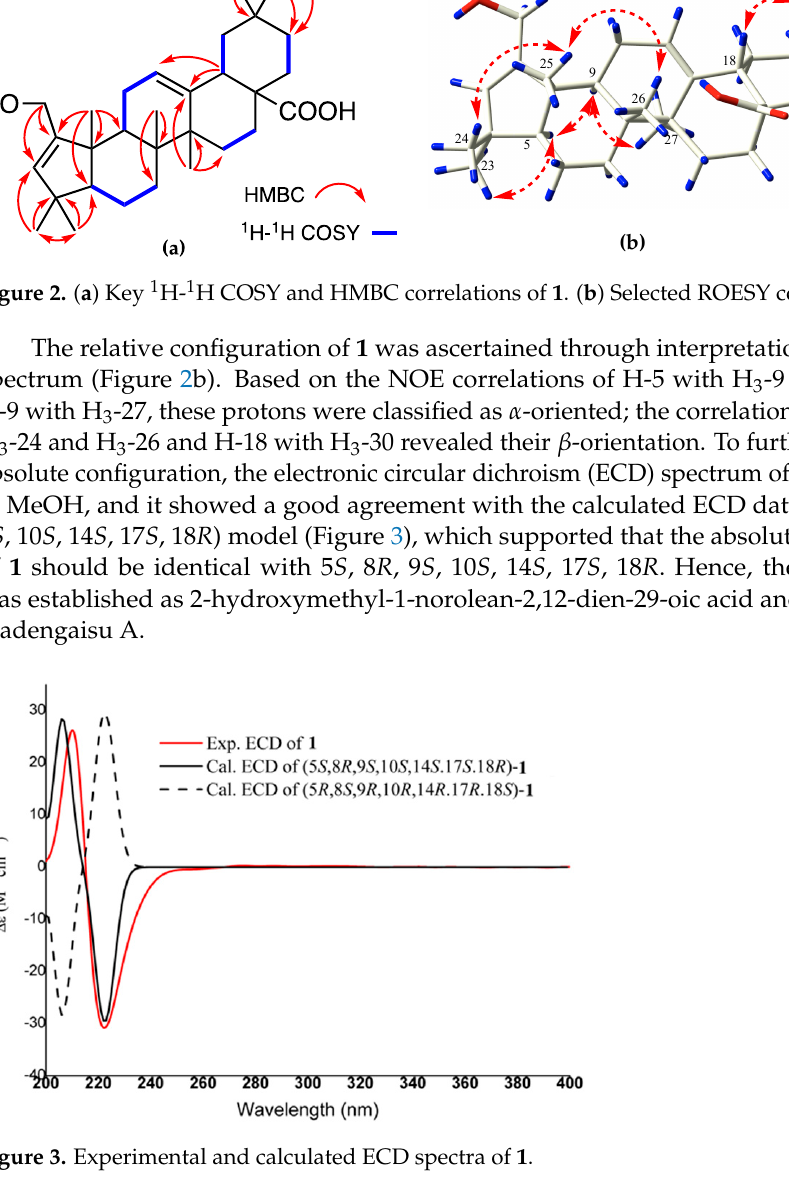
Figure 3. Experimental and calculated ECD spectra of 1 . Compound 2 appeared as a white and amorphous powder. The molecular formula C 30 H 46 O 3 and eight degrees of unsaturation are the same as those of 1 , based on HR-ESI- MS ( m / z 477.3342 [M + Na] + , calculated for C 30 H 46 NaO 3 , 477.3361) and 13 C NMR data (Figure S12). The NMR data (Table 1) of 2 were almost identical with those of compound 1 , except that there was a ursane-type skeleton instead of oleanane; hence, the presence of five tertiary methyls at δ H 0.90, 0.95, 1.03, 1.15, and 1.16 (each 3H, s) and two methyl doublets at δ H 0.96 (d, J = 4.8 Hz, 3H) and 0.90 (d, J = 6.6 Hz, 3H) in the 1 H-NMR spectrum was inferred. Additionally, a H-18/H-19/H-20/H 2 -21/H 2 -22 long fragment of the 1 H- 1 H COSY spectrum and HMBC correlations also supported the planar structure of 2 (Figure 4). Its stereochemistry is similar to that of 1 , and the β -orientation of H 3 -29 was deduced from the ROESY cross-peaks between H-18 and H 3 -29 (Figure 4). In the experimental ECD data, 2 showed a positive cotton effect at 203.4 nm and a negative cotton effect at 222.6 nm, which was consistent with the calculated ECD data of the (4 S , 5 S , 8 R , 9 S , 10 R , 14 S , 17 S , 18 R , 19 S , 20 R ) model (Figure 5). Thus, the structure of 2 was established as 2-hydroxymethyl-1- norursa-2,12-dien-29-oic acid and it was named madengaisu B